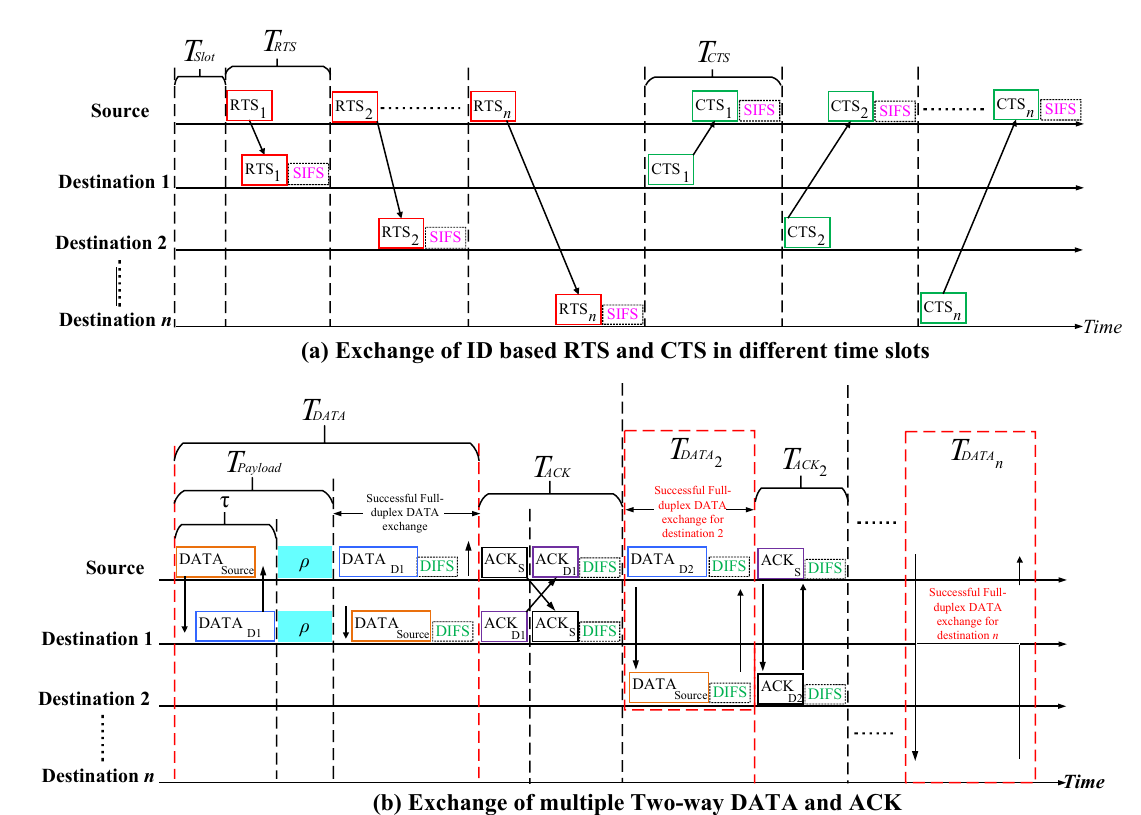
Figure 6. Simultaneous transmission of control and data packets though E-FD-MAC. Table 5. Comparison of various FD-MAC layer-based UWAC protocols.